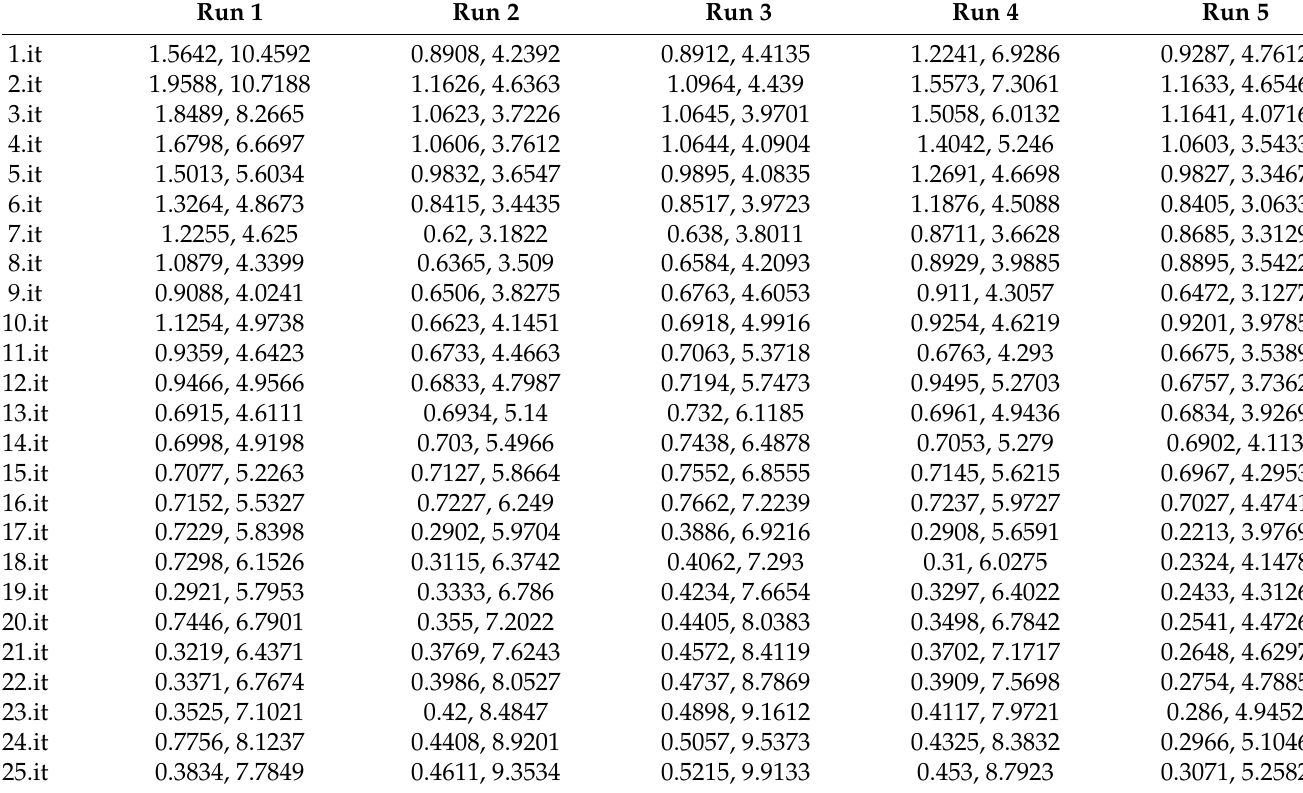
Table 10. The distances (Euclidean, Manhattan) between the testing algorithm and the proposed algorithm for (cid:96) =